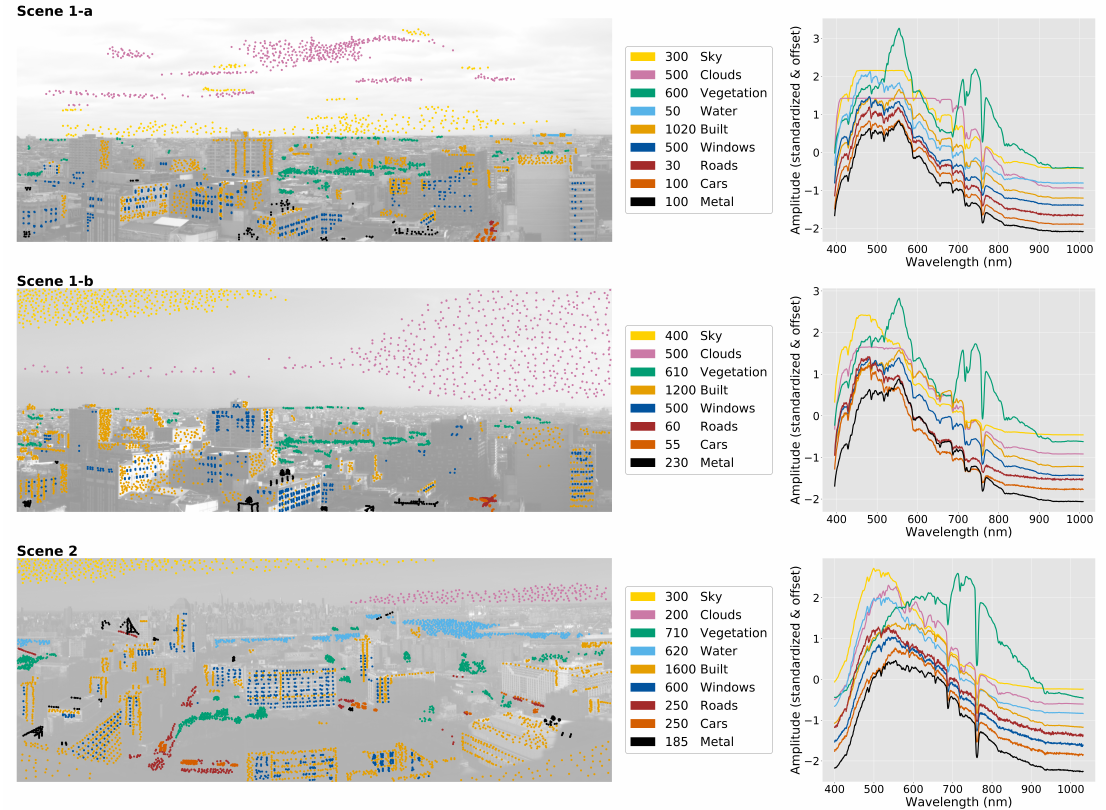
Figure 3. ( left ) Locations of manually classified pixels superimposed over a grayscale image of the scenes in Figure 1. ( center ) The color code and number of pixels for each class. Manually labeled pixels’ locations were chosen to be broadly representative of the spatial distribution of each class in the scene. ( right ) Mean of the standardized pixel spectra for each class of manually classified pixels in each scene (with a constant offset added to each spectrum for visual